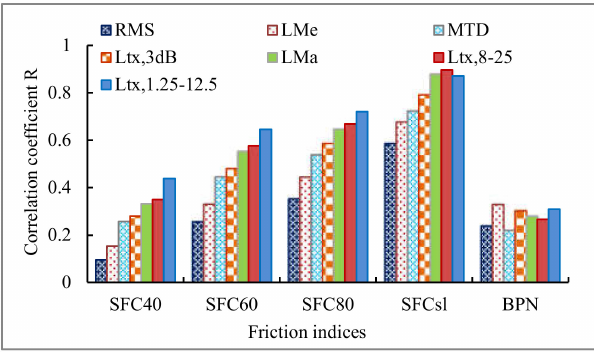
Figure 6. Pearson correlation coe ffi cients R between six texture parameters and five friction